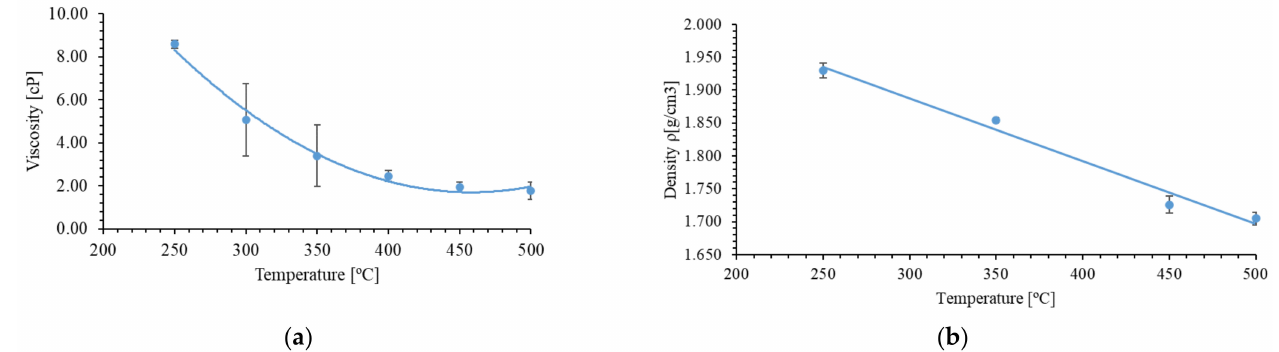
Figure 4. ( a ) Viscosity value of 60% NaNO 3 -40% KNO 3 at different temperatures, ( b ) Solar Salt density values from 250 ◦ C up to 500 ◦ C.